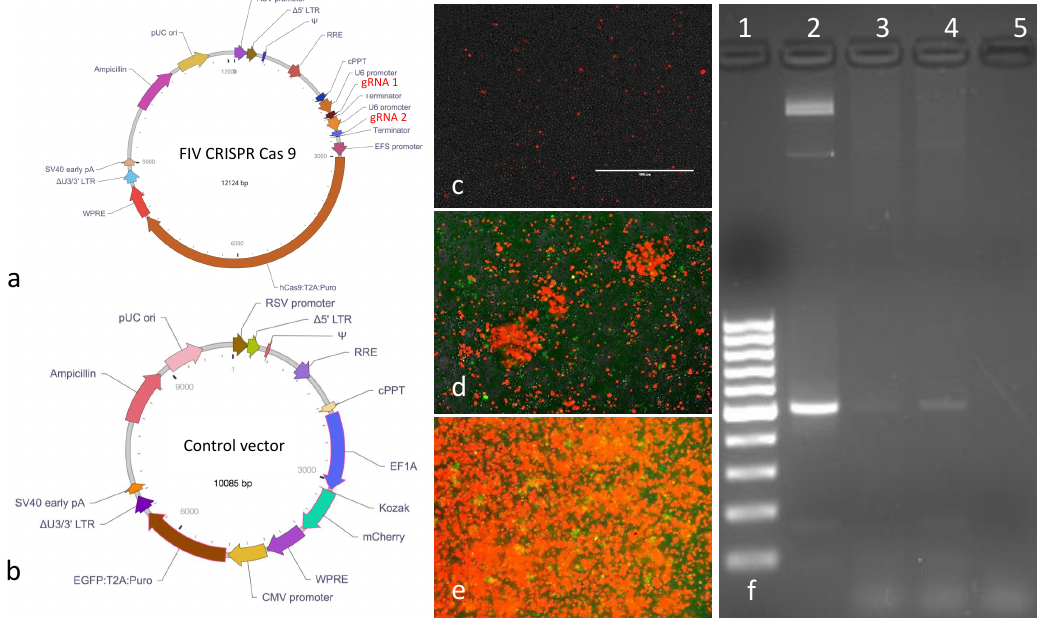
Figure 3. Schematic diagrams of the ( a ) FIV CRISPR Cas9 and ( b ) control vectors. Fluorescent microscopy images of MCH5-4 cells infected with the control vector for 2, 6, or 17 days ( c , d , or e , respectively). Images d and e wereobtainedduringselection(puromycin). ( f )Ethidiumbromide-stained agarose gel electrophoresis of PCR amplicons (FIV CRISPR Cas9 nucleotides 2166-2691). The black arrowhead indicates 500 base pairs (appropriate sized amplicon). Lane 1—molecular weight markers, lane 2—plasmid DNA (positive control), lane 3—FIV CRISPR Cas9 infected / selected feline PBMC, lane 4—feline MCH5-4 cells, lane 5—water template (negative